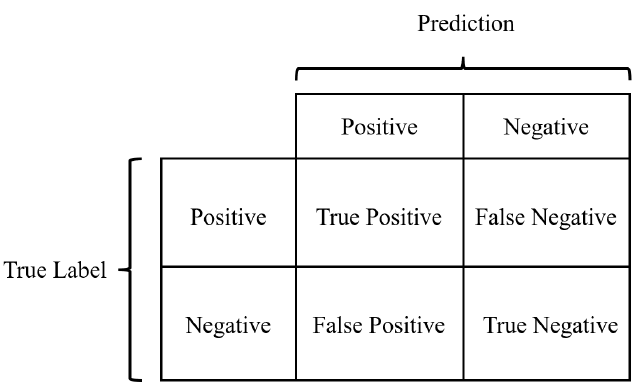
Figure 4. Schematic diagram of the confusion matrix for the binary classification task.